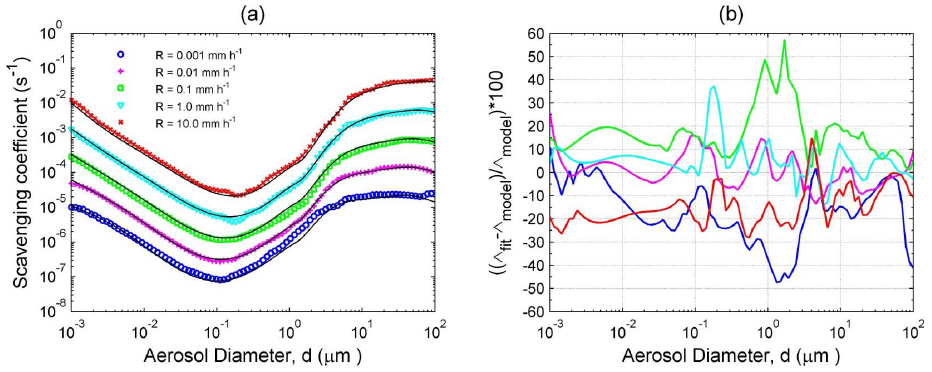
Fig. 6. Same as in Fig. 3 except for 3 snow .